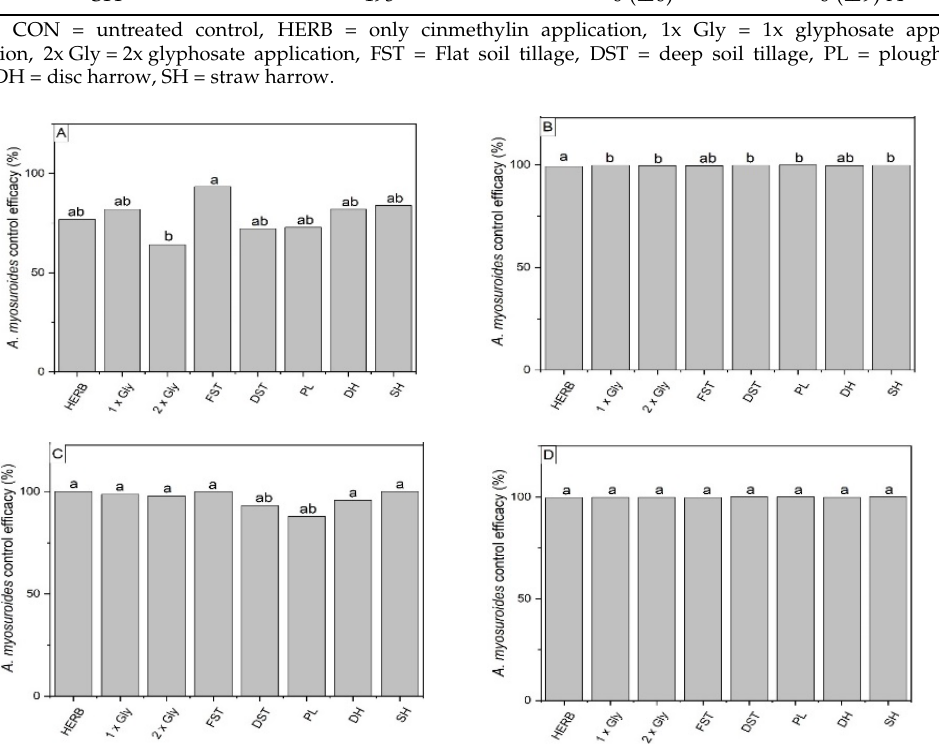
Figure 1. A. myosuroides control efficacy recorded at ( A ) Binsen 56 DAS, ( B ) Binsen 120 DAS, ( C ) Risp 56 DAS and ( D ) Risp 120 DAS from 2019 to 2020. The application rate of cinmethylin is included in the upper right corner. Means with different letters show significant differences between the treatments according to Tukey’s HSD test at α ≤ 0.05. CON = untreated control, HERB = only cinmethylin application, 1x Gly = 1x glyphosate application, 2x Gly = 2x glyphosate application, FST = Flat soil tillage, DST = deep soil tillage, PL = ploughing, DH = disc harrow, SH = straw harrow. At the experimental site B. Kreuz, 56 DAS, significant interaction between herbicide rate and stubble management strategy were observed. The highest control efficacy of over 94% was achieved by all stubble management strategies in combination with a cinme- thylin rate of 495 g a.i.. The A. myosuroides control efficacy decreased at cinmethylin rate 375 g a.i. and 0 g a.i., respectively. All stubble management strategies within the applica- tion dose of 375 g a.i. achieved control efficacies of over 89% with the exception of FST (72%) and PL (79%). The stubble management strategies without herbicide application achieved control efficacies of over 89% with the exception of FST and 1x glyphosate (1x Gly), which showed a reduced efficacy of 83% (Figure 2A). In spring, 120 DAS, no significant differences between the herbicide rates could be detected. The highest control efficacy of 87% was achieved by the treatment of false seed- bed preparation followed by a rotary hoe (FSB + m). The poorest effect was observed for the stubble management strategy FST with 62% efficacy (Figure 2B). At the second experimental site Sieben Jauchert in 2020, significant differences be- tween the herbicide rates were detected. On average, across all stubble management strat- egies that had not been treated with cinmethylin, a 30% reduction in control efficacy was observed compared to the 375 g a.i. and 495 g a.i. rates 56 DAS (Figure 2C). In the subsequent year, 120 DAS, a significant interaction between the herbicide rate and the stubble management strategy was detected. At this experimental site, big differ- ences were visible between the cinmethylin-treated plots and the untreated plots. Within the cinmethylin rate of 495 g a.i., control efficacies of over 87% were observed. The highest control efficacy of 100% was detected within the false seedbed preparation followed by a glyphosate application (FSB + Gly) and DST. A reduced control efficacy of 85% was ob- served by PL and FSB + m. As at the experimental site B. Kreuz, all stubble management strategies in combination with 375 g a.i. achieved a control efficacy of minimum 89%. The highest control efficacy of 99% was achieved by double glyphosate application (2x Gly)